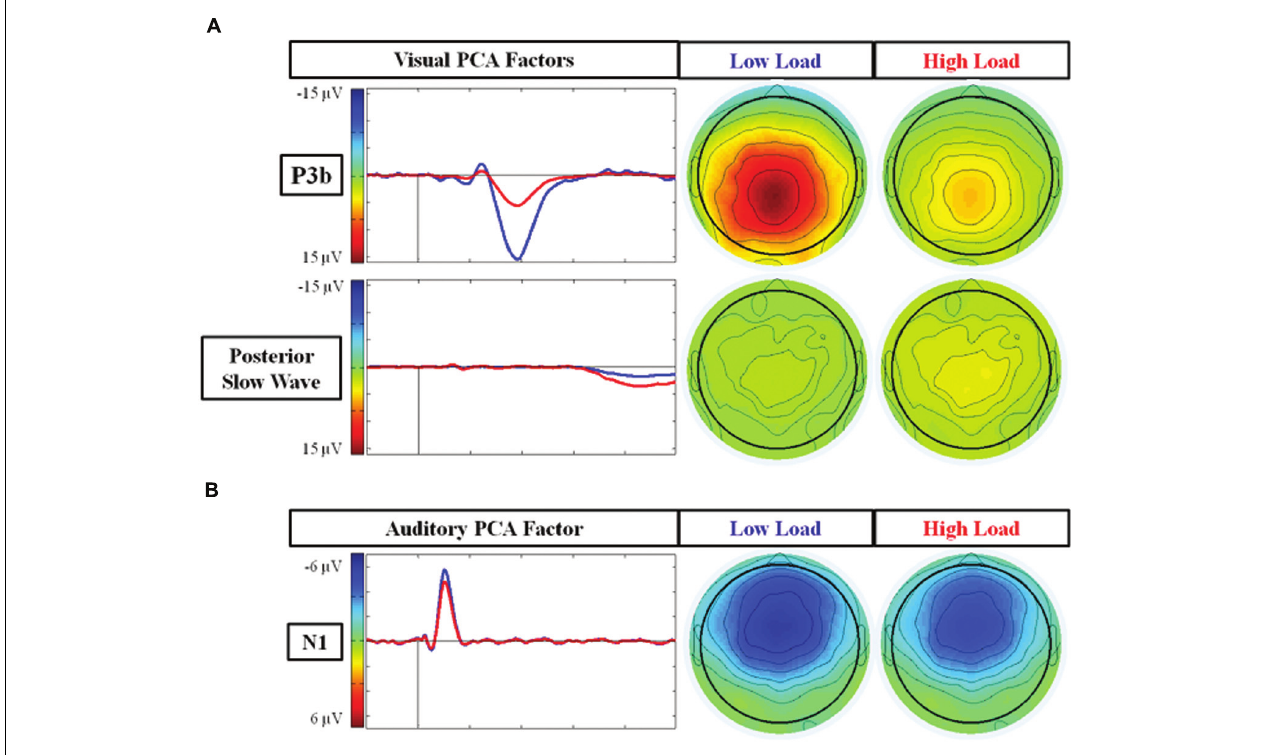
FIGURE 4 | Scalp topographies and waveforms of PCA factors under the low and high load conditions. (A) Illustrates the PCA factors reflecting the P3b component (TF2SF1) and posterior SW (TF3SF1); and (B) represents the PCA factor reflecting the N1 component (TF4SF1). TF, Temporal Factor. SF, Spatial